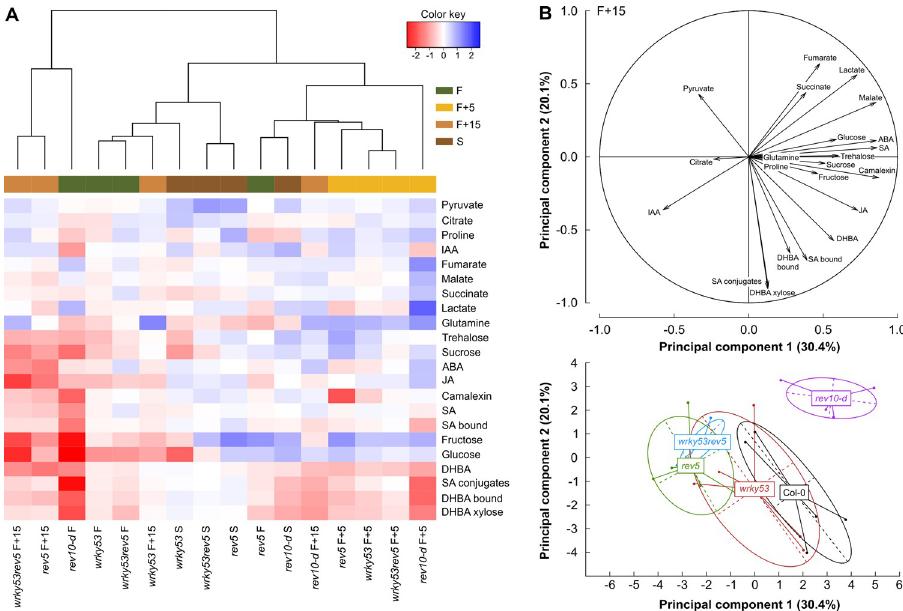
Fig 2. Metabolite patterns in REV and WRKY53 mutants over development. (A) Heat map analysis of metabolites in REV and WRKY53 mutants compared to wild-type Col-0. The row represents metabolites and the column displays the different genotype-stage combinations. The colour scale indicates the values of response ratio, calculated between the average of log-transformed values of Col-0 and a mutant at a given stage. Metabolite decreased is displayed in red, while metabolite increased is displayed in blue. White colour indicates no difference. The brightness of each colour corresponds to the magnitude of difference in the response ratio. The dendrogram represents the proximity between each genotype-stage metabolic pattern, as calculated from a hierarchical clustering analysis using Manhattan distance measures and Ward’s hierarchical clustering method. (B) Principal component analysis on metabolite abundance values at 15 days after flowering. Top : representation of metabolites on the two first principal components. Bottom : projection of individual plants with centres of gravity per genotype (n = 5). See also S1, S2 Tables and S2 Fig. IAA = auxin, ABA = abscisic acid, JA = jasmonic acid, SA = salicylic acid, SA bound = total SA after hydrolysis—free SA, SA conjugates = SA-(C6)-glycosides, DHBA = dihydroxybenzoic acid; DHBA bound = Total DHBA after hydrolysis—free DHBA; F = flowering; d = days and S = mature silique stage.